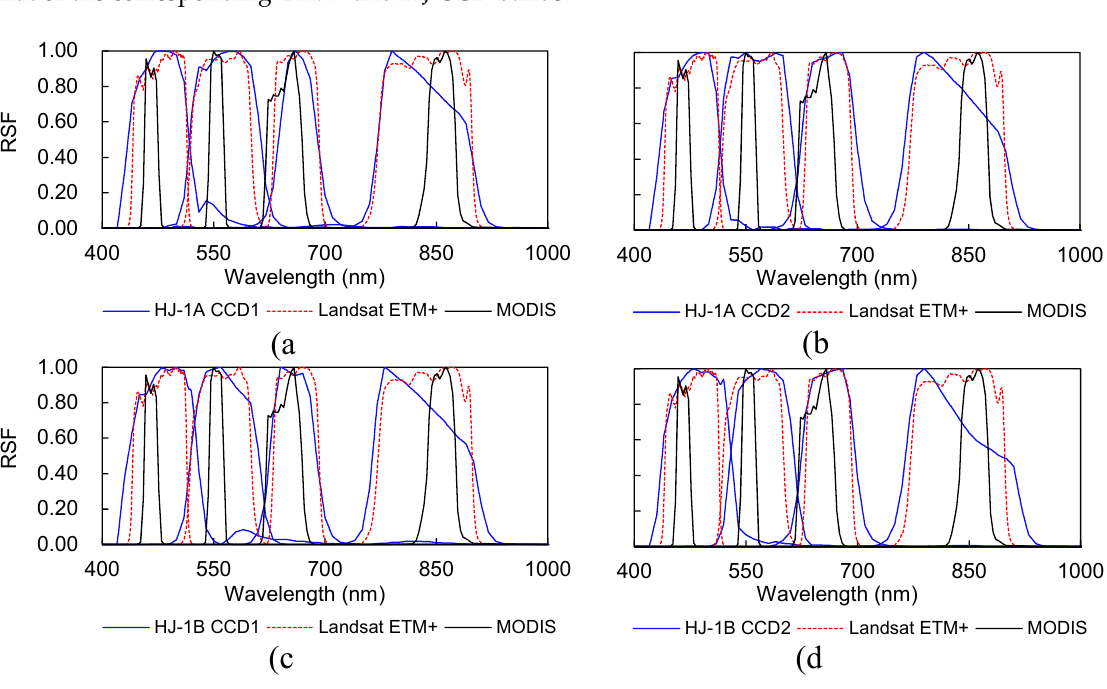
Figure 2. Relative spectral response functions (RSF) for HJ-1A/B CCD cameras (( a – d ) are HJ-1A CCD1, HJ-1A CCD2, HJ-1B CCD1, HJ-1B CCD2, respectively), Landsat 7 Enhanced Thematic Mapper Plus (ETM+) and MODIS.